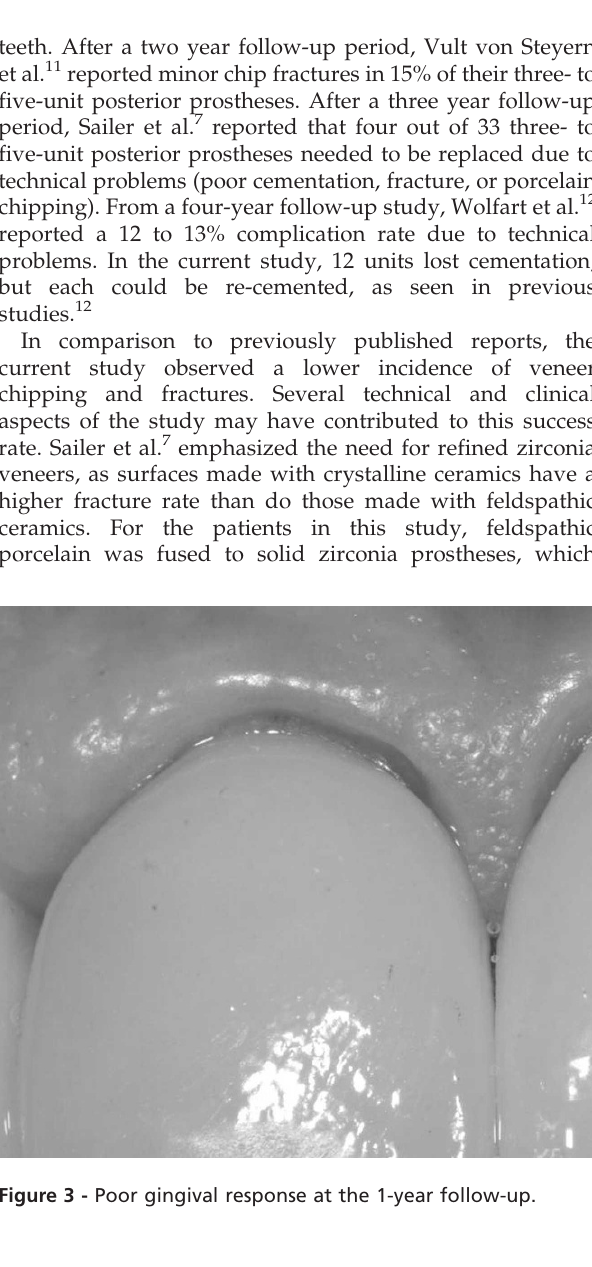
Figure 2 - Minor chipping of the anterior zirconia prosthesis on tooth 11.